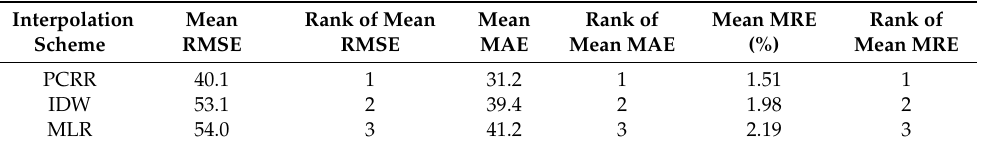
Table 4. Cross-validation performance and ranking of different interpolation schemes for simulating annual precipitation.